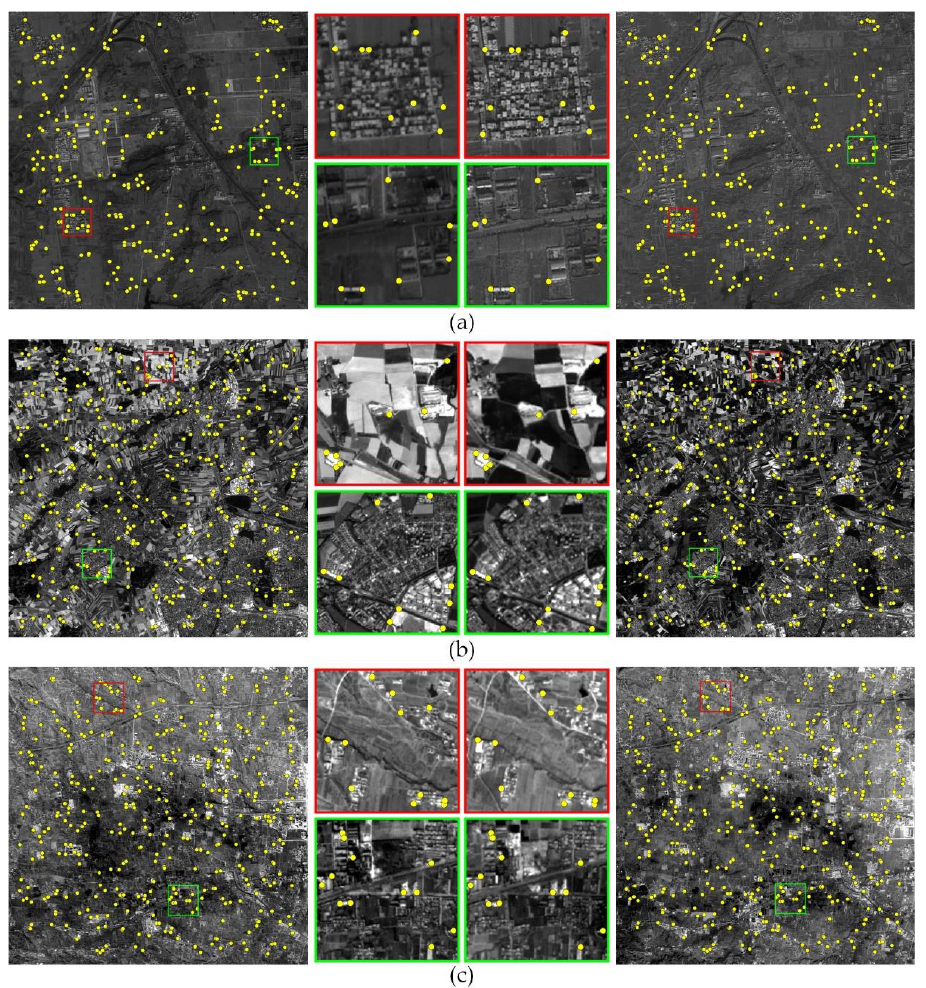
Figure 3. Tie points achieved by the enhanced subpixel PC method with the template size of 80 × 80 pixels for three test image pair. ( a ) Data 1; ( b ) Data 2; and ( c ) Data 3.